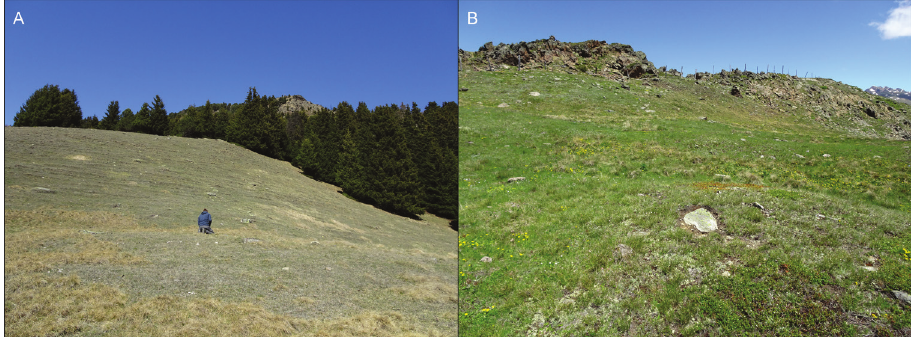
Figure 2. Photographs of the steppe-like dry pastures at the “Muntatschinig” site where Opetiopalpus sabulosus Motschulsky, 1840 was first recorded. The sites are part of the LTSER area “Val Mazia/Matscher- tal” at the research site “Muntatschinig” A P2000_1: photograph 2A was taken on 4 th May 2016. In the background the “Spitzige Lun/Piz Lun” peak can be seen B P2500_2: photograph 2B was taken on 19 th June 2018. The rocky “Niederjoch/Giogo Basso” peak can be seen in the left upper corner.